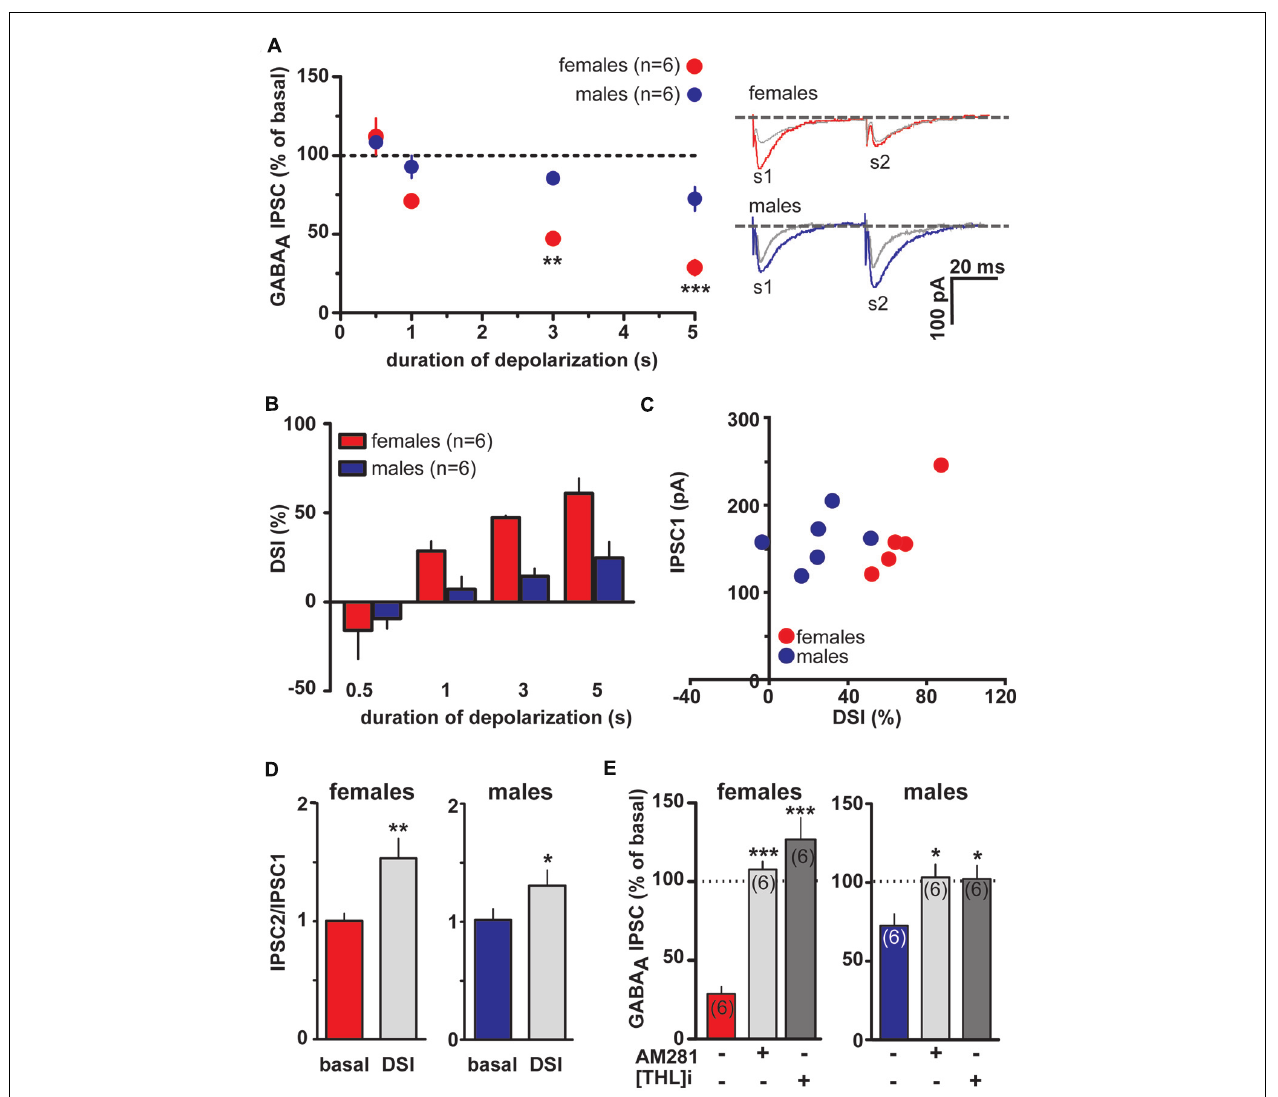
FIGURE 3 | Endocannabinoid modulation of inhibitory transmission arising from rostral afferents is reduced in male LH rats. (A) The relationship between the depolarizing pulse duration and the relative amplitude of GABA A IPSCs obtained after 5–15 s after the end of depolarization is plotted (left panel). GABA A IPSCs amplitude was normalized to the averaged value (dotted line) before depolarization. Each symbol represents the averaged value obtained from different cells. Representative traces before and after DSI (5 s) are overlaid and shown (right panel). Gray traces represent the GABA A IPSCs after the depolarizing step. (B) Averaged